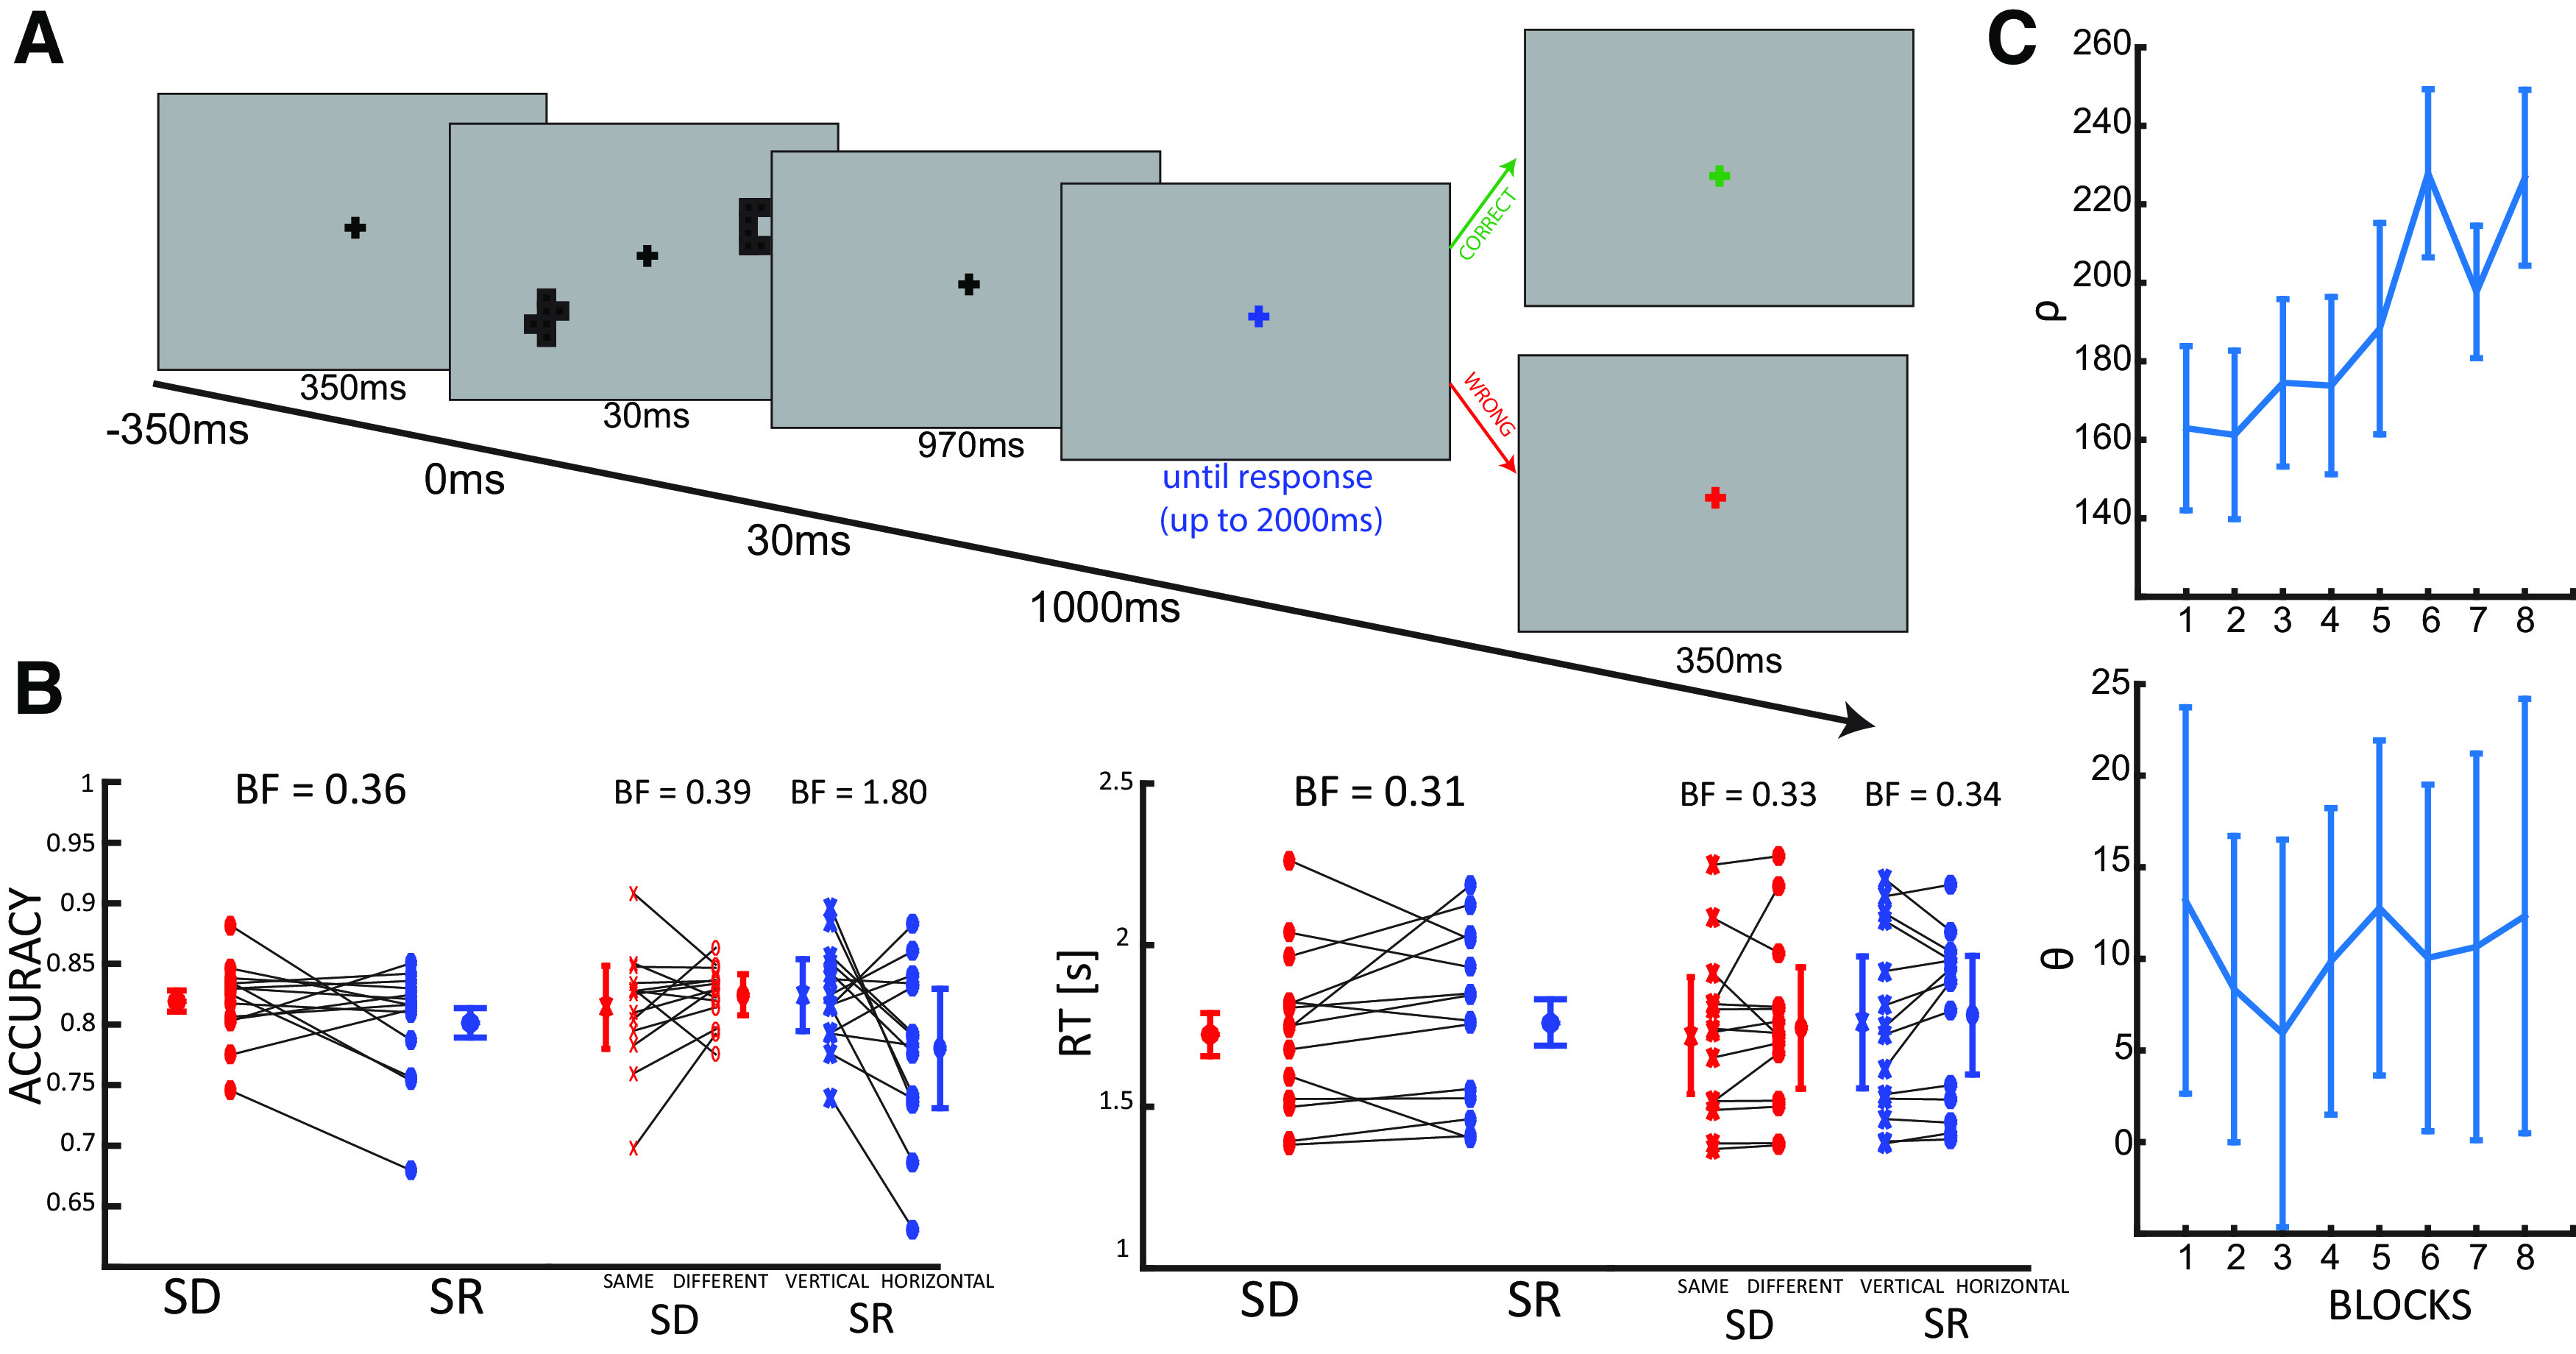
Experimental design and human behavioral results. A, At the beginning of each trial, a black fixation cross was displayed for 350 ms. After two stimuli were shown for 30 ms, participants waited an additional 970 ms before providing the answer. The response was cued by the fixation cross turning blue. After the response, the color of the fixation cross provided feedback: green if the response was correct, red otherwise. B, Humans performed the SD and SR tasks with comparable levels of performance. In the left and right panels are shown the averages ± SE for accuracy and RTs, respectively. Each pair of connected markers represent an individual subject. The results for the SD (in red) and SR (in blue) conditions are further broken down for each condition separately (SD and vertical-horizontal). BF indicates the BF against the null hypothesis (difference between the two conditions). C, Changes over blocks of ρ (the distance between the stimuli, left panel) and θ (the angle between the stimuli and the meridian, right panel) as adjusted by the QUEST algorithm.